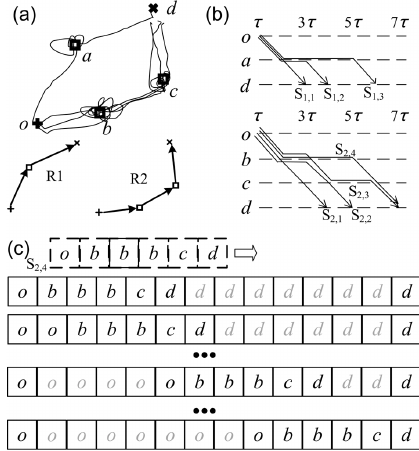
Figure 2. Possible routes and schedules during a gap. ( a ) Two possible routes from origin + to destination × indicated by historical data. ( b ) Multiple possible schedules for route R1 (upper) and R2 (lower). The horizontal axis is time and the vertical axis is places along each route. Horizontal lines represent stays at a place and inclined lines represent moves between places. ( c ) Sliding windows of schedule S 2,4 on a gap that is much longer than the schedule. The first row shows S 2,4 as a discrete sequence of places. Each of the rows below moves the sequence by one time unit along the gap, and the schedule is padded (grey) with origin on the left and destination on the right. The frequency of each route and schedule is used as a weight when aggregating visit probability distributions of different routes. Corresponding frequencies are counted ac- cording to empirical schedules for each route in historical data.